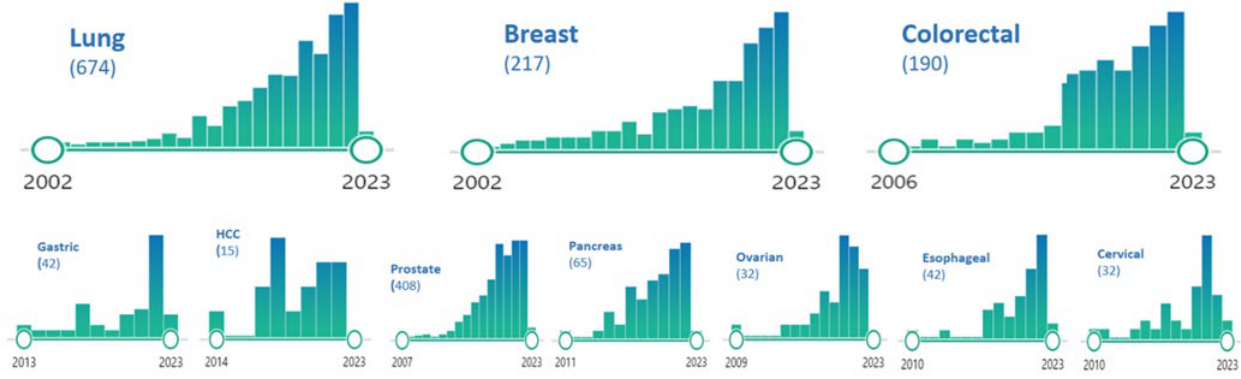
Figure 1. Literature analysis (number per year) of articles dealing with OMD (until January 2023). Table 1. Incidence of oligo - metastatic patients at diagnosis among metastatic patients in the ten most common cancers. Cancer